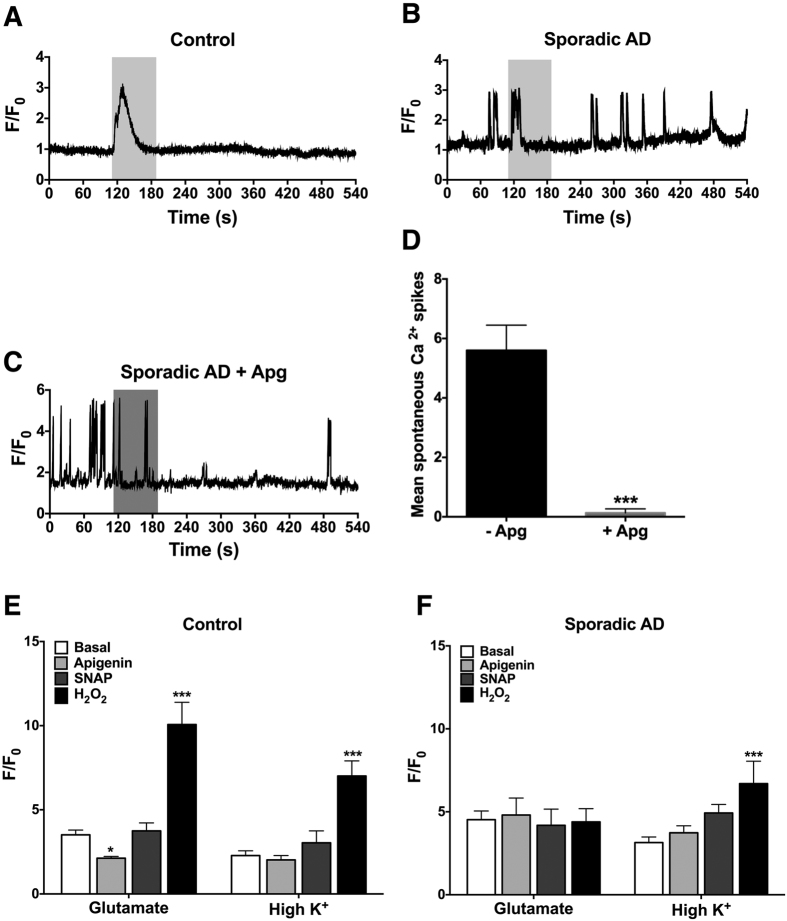
Representative images of Ca2+ imaging traces in (A) control, (B) sporadic AD derived neurons and (C) sporadic AD derived neurons exposed to apigenin. Neurons were loaded with fluorescent Ca2+ indicator Fluo3-AM and data are represented as mean change in fluorescence from baseline (F/F0) over time. Application of 60 mM KCl (high K+) or 50 μM apigenin is represented as the light or dark shaded area, respectively. Mean relative change in fluorescence was calculated from (D) control and (E) sporadic AD derived neurons. Loaded neurons were perfused with 50 μM apigenin, 300 μM H2O2, or 10 μM SNAP prior to 200 μM glutamate or 60 mM high K+. Data are presented as mean ± SEM of three independent experiments from >30 cells. Significant difference from basal response was calculated using two-way ANOVA with Tukey’s multiple comparisons test and is indicated by ***p ≤ 0.001.